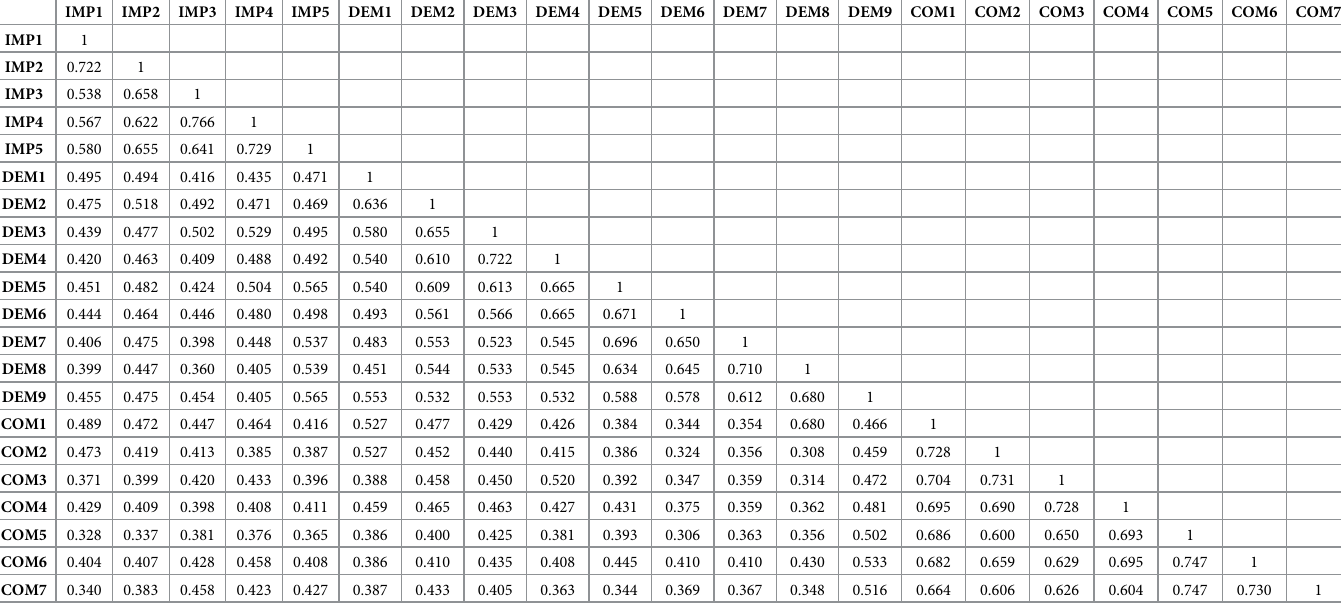
Table 2. Polychoric correlation matrix for items of